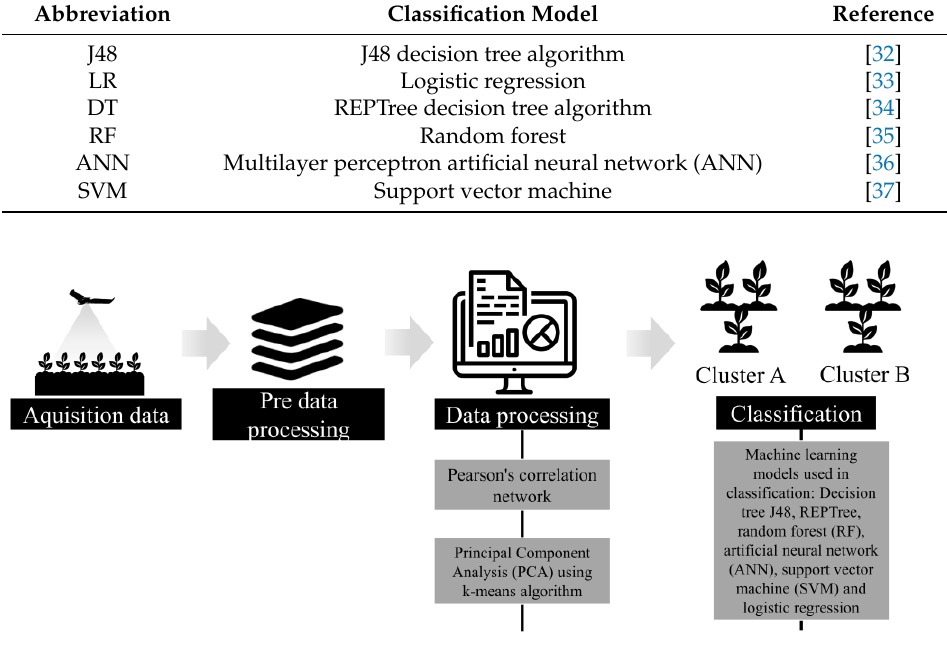
Figure 2. Summary of processes carried out in data